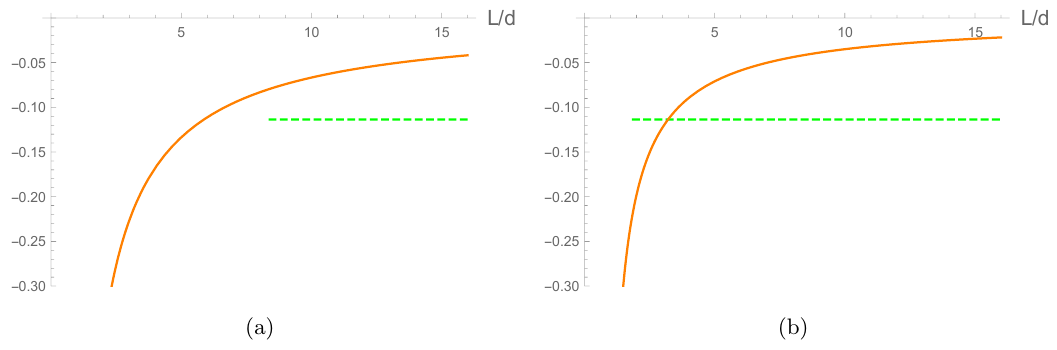
Figure 5 . Rescaled potentials (cid:22) V disc (orange, solid) and (cid:22) V conn (green, dashed) in (4.2). Left panel: the system with (cid:30) = 45 (cid:14) , (cid:31) (cid:0) = 20 (cid:14) , (cid:31) + = 30 (cid:14) , (cid:20) = 5 shows a zeroth-order transition at L=d = L 0 =d 0 (cid:25) 8 : 39. Right panel: the system with (cid:30) = 45 (cid:14) , (cid:31) (cid:0) = 70 (cid:14) , (cid:31) + = 80 (cid:14) , (cid:20) = 1 shows a (cid:12)rst-order transition at L=d = L 1 =d 1 (cid:25) 3 :